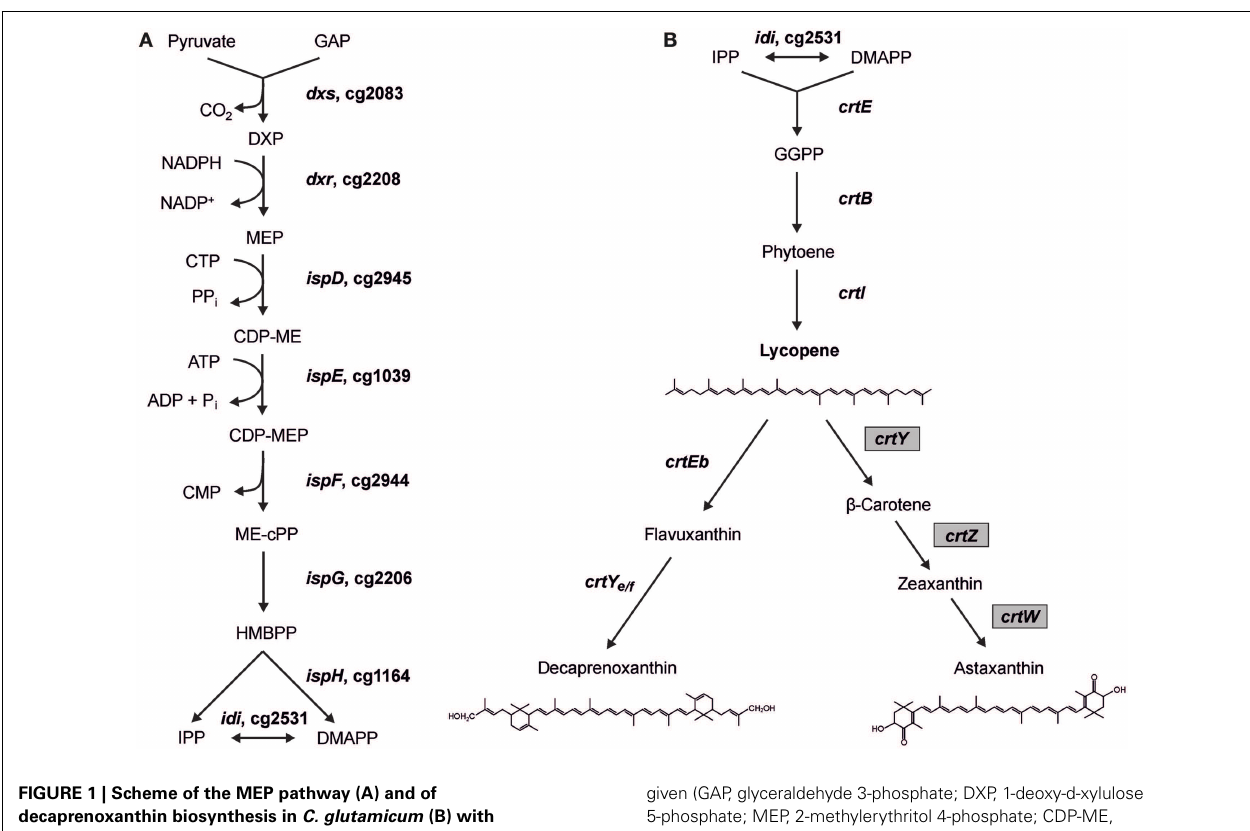
FIGURE 1 | Scheme of the MEP pathway (A) and of decaprenoxanthin biosynthesis in C. glutamicum (B) with heterologous astaxanthin biosynthesis . Gene names from C. glutamicum (and gene IDs for MEP pathway genes) as well as gene names from Pantoea ananatis and Brevundimonas aurantiaca (gray boxes) are indicated.The structures of the endogenous C50 carotenoid decaprenoxanthin and the heterologous C40 carotenoid astaxanthin are